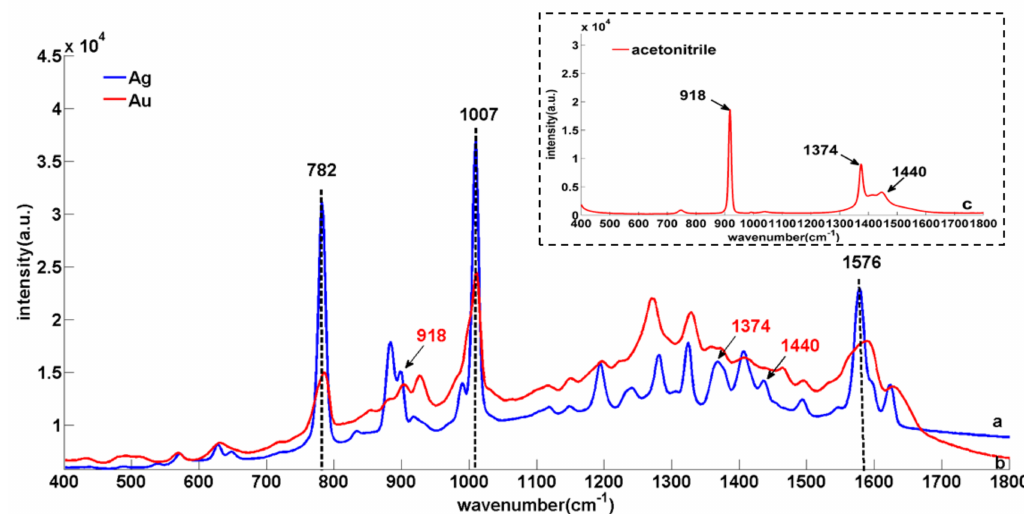
Figure 4. The Surface Enhanced Raman Spectroscopy (SERS) of the thiabendazole standard solution (100 mg/L) with silver and gold nanoparticle: ( a ) Silver; ( b ) gold; ( c ) acetonitrile.